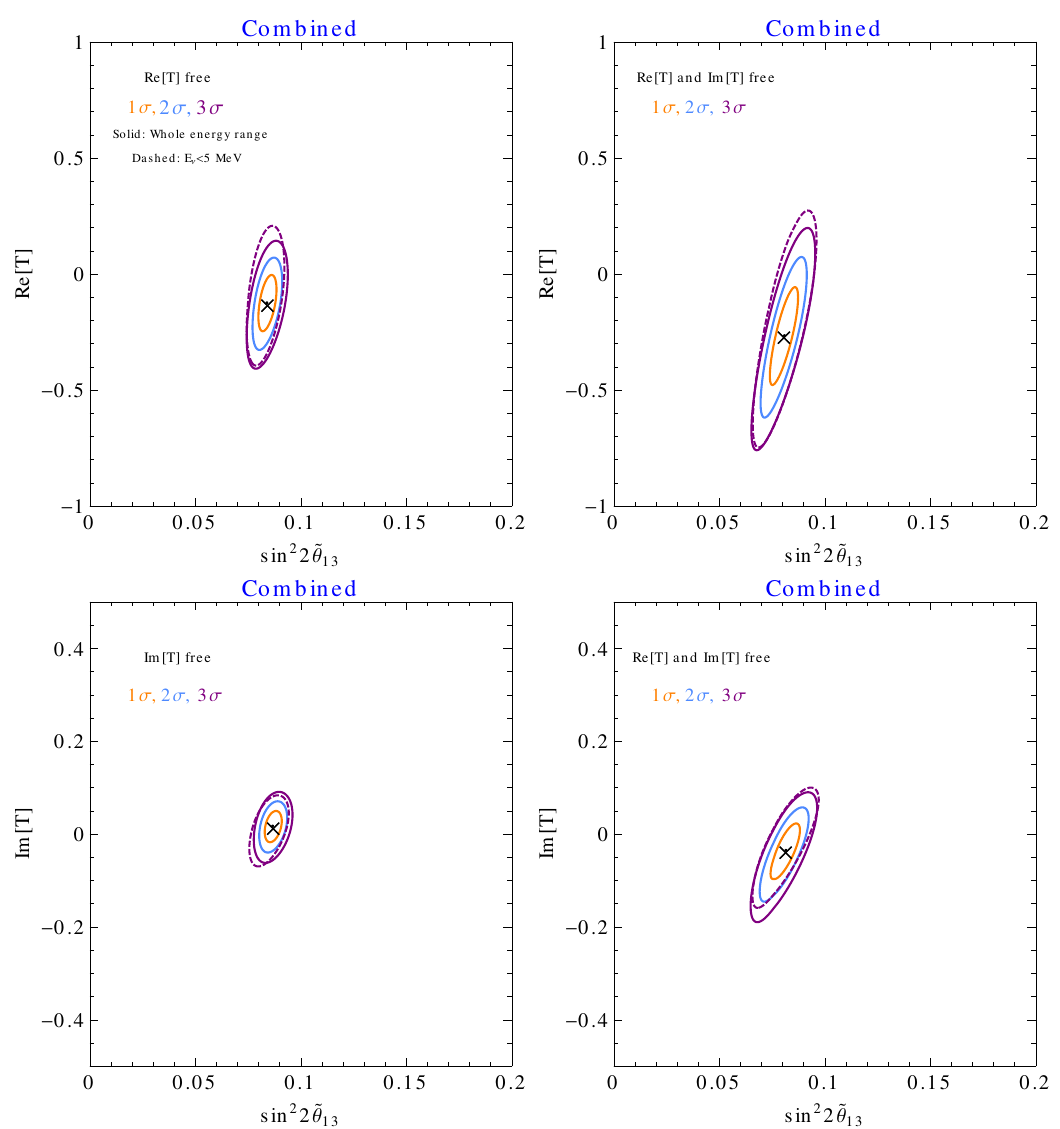
Figure 3 . Allowed regions in the (sin 2 2~ (cid:18) 13 (cid:0) Re [ T ]) ((cid:12)rst row) and (sin 2 2~ (cid:18) 13 (cid:0) Im [ T ]) plane (second row) for the combined data of the Daya Bay and RENO experiments. The 1-, 2-, and 3- (cid:27) regions are shown with orange, blue, and purple, respectively. The best (cid:12)t values are marked by (cid:2) . In the left panels only Re [ T ] (Im [ T ]) is varied at a time, while in the right panels both vary simultaneously. The dashed curves correspond to the 3- (cid:27) regions in the analysis where only events with E (cid:23) < 5 MeV are taken into account. We note that the y-axis range is di(cid:11)erent in the upper and lower